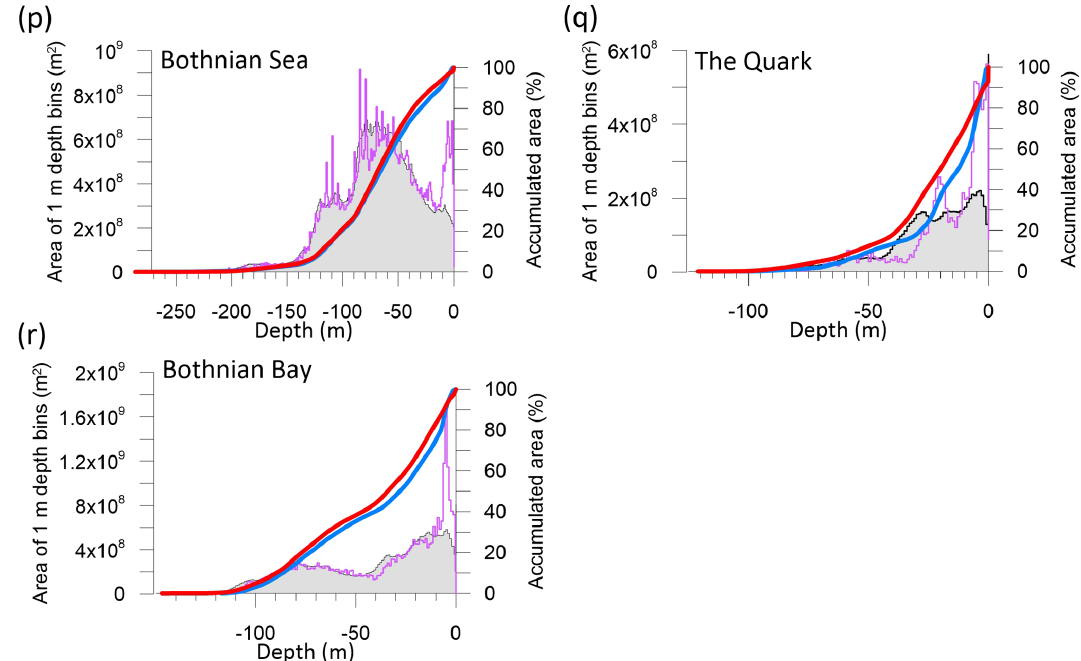
Figure 2. Hypsometry of the Baltic Sea and the 17 HELCOM-defined sub-basins. (a) Hypsometry of the entire Baltic Sea, (b–r) Hypsometry of HELCOM-defined sub-basins. Hypsometry expressed as accumulated area in percent are shown with red curves for EMODnet and blue for IOWTOPO. Hypsometry expressed as area for 1m depth intervals are shown with filled grey curves for EMODnet and with purple curves for